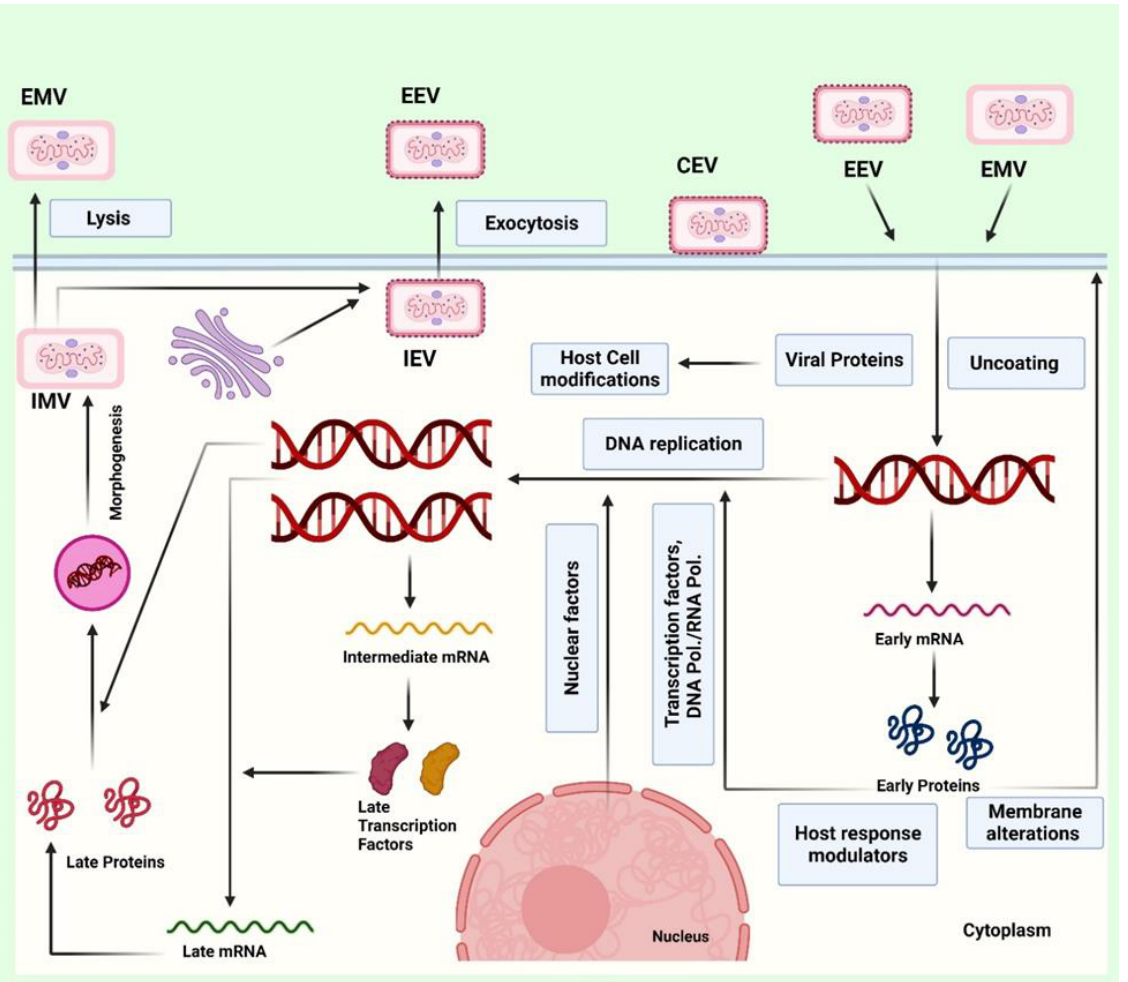
Figure 2. The figure represents the infection mechanism by which extracellular mature virion (EMV) or extracellular enveloped virus (EEV) infect the human cell and hijack the host machinery. The viral particles enter or penetrate the host cell through fusion and macropinocytosis, then replicate and infect the host cells. The genetic material replicates in the host cell and transcribes to produce the viral proteins with the help of host translation proteins. The genetic material and the viral pro- teins assemble in the host cell and are lysed through exocytosis. The assembled viral particles excy- tosed in the form of EMV and EEV.